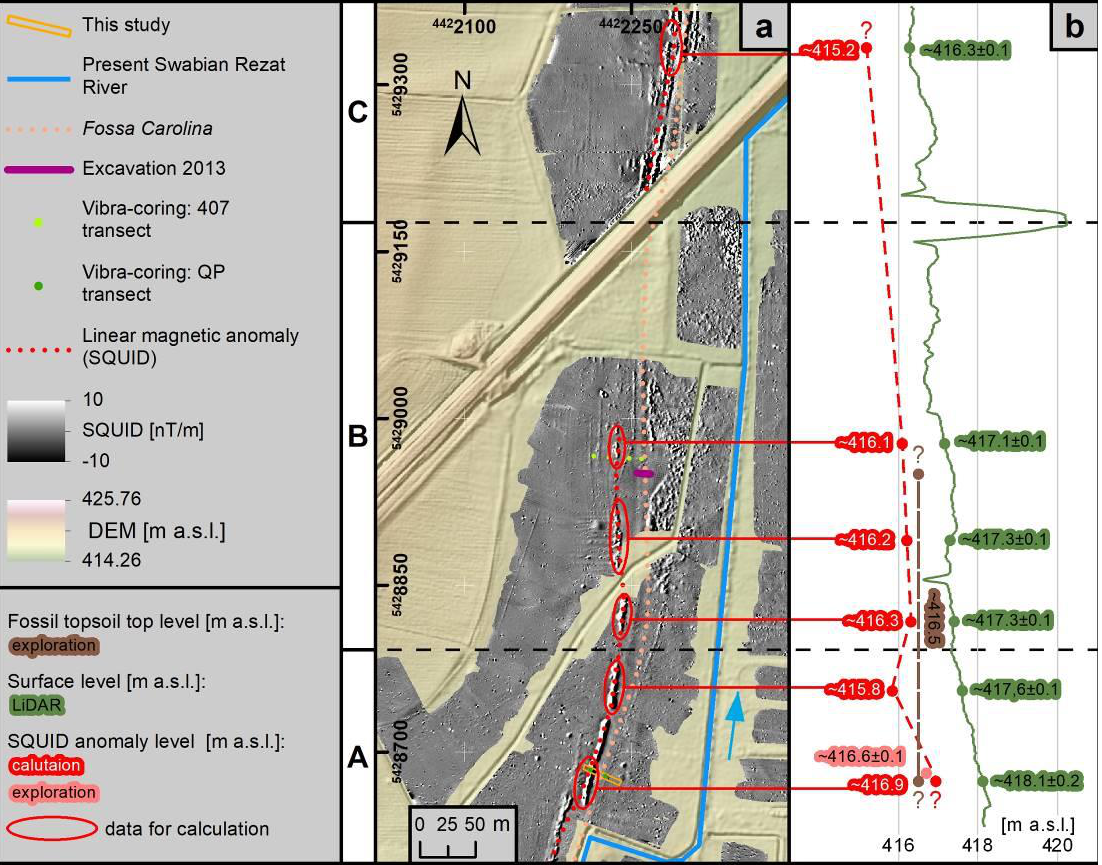
Figure 6. Depth calculation of the intensive magnetic anomaly based on the SQUID magnetic survey. ( a ) Passage A shows the comparison for our study site. Passage B complements the northern section. Passage C offers the continuation in the north-eastern section. Data from the 2013 excavation [4] and the vibracoring cross-section 407 [39] are provided for comparison. ( b ) Elevation profile of the data along the canal. (Database: LiDAR data are provided by Bavarian Land Surveying Office)